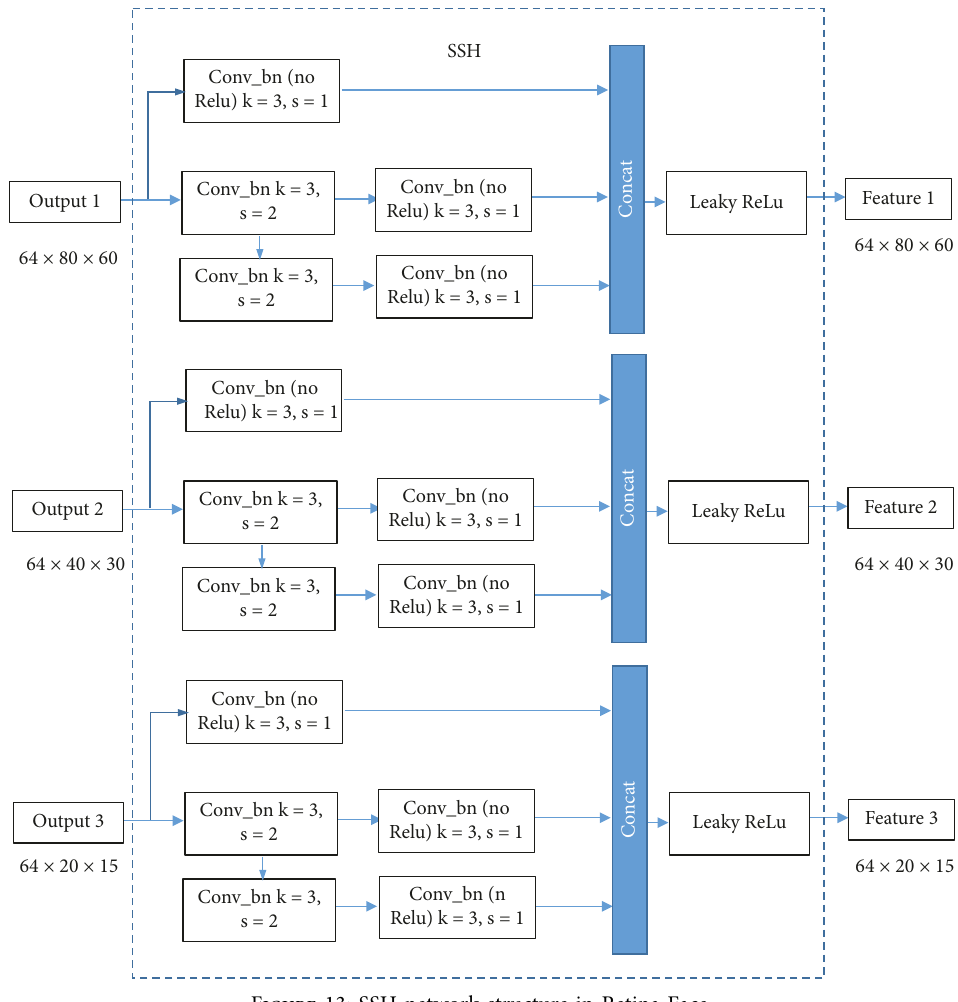
Figure 13: SSH network structure in Retina